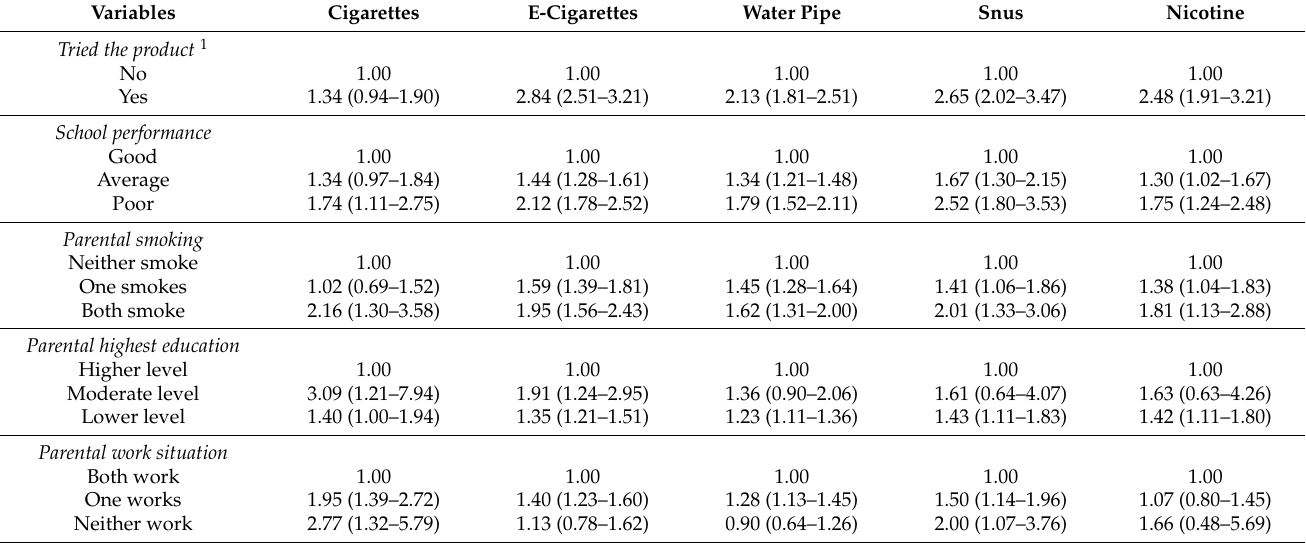
Table 3. Age and gender adjusted Odds Ratios (ORs) and 95% CIs for adolescents who reported that cigarettes, e-cigarettes, water pipe, snus, and nicotine are not harmful to health, by experimentation with the product and by socio-economic background.